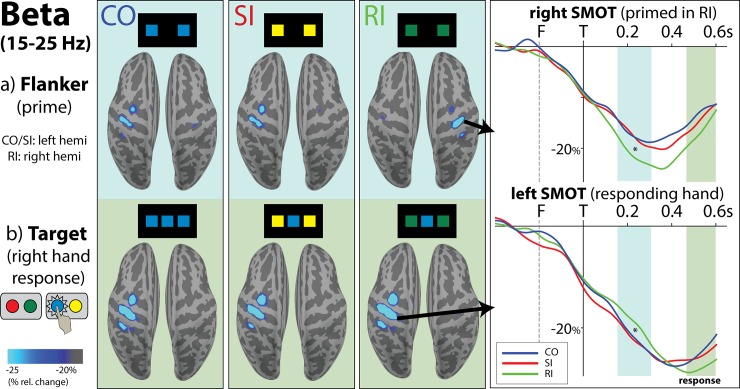
Activation maps and timecourses for event-related beta power expressed as percent change from pre-flanker baseline.‘F’ and ‘T’ correspond to flanker (at -200 ms) and target (0 ms) presentation respectively. Beta power in the early time window (150-300ms), highlighted in blue, is sensitive to response preparation primed by the flanker: in this example, CO and SI prime the left hemisphere (correct response hand), as shown with greater beta decrease (timecourse shown in bottom right panel). In RI, the right hemisphere is incorrectly primed by the flanker as shown with beta decrease to RI (timecourse shown in upper right panel). Upon the presentation of the response-incongruent target, the response preparation is switched to the opposite hand to make a correct response. During the late time window (450-600ms), highlighted in green, stronger beta decrease in the correctly-responding left hemisphere is seen in all conditions. Therefore, the relative changes in beta power track motor preparation in real time. Only correct trials requiring a right-hand response are shown here, but the findings on left-hand trials are a mirror image of the pattern shown above.